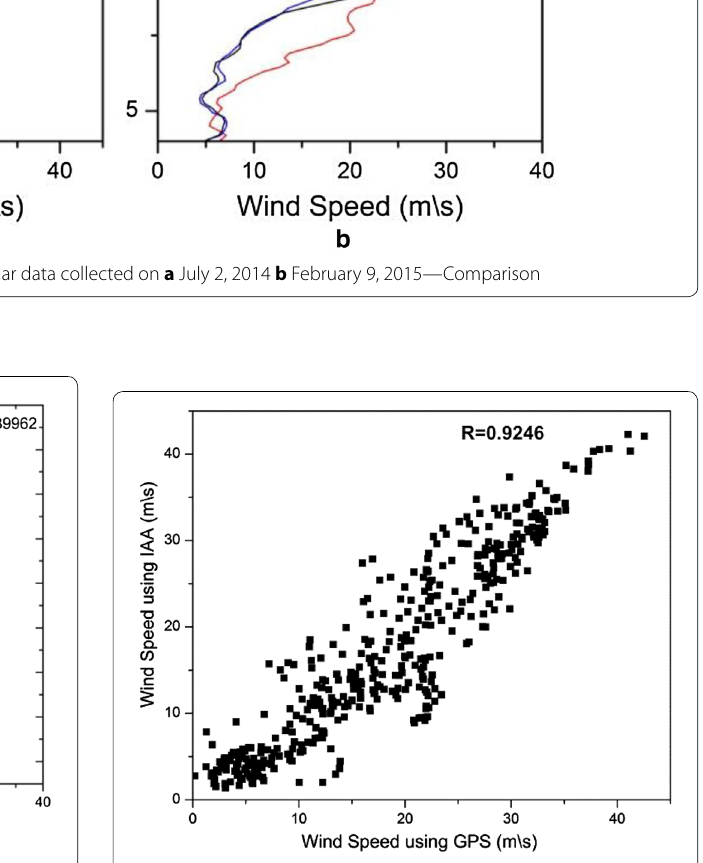
Fig. 10 Correlation between IAA and GPS wind speeds for data dur- ing 9th–12th February